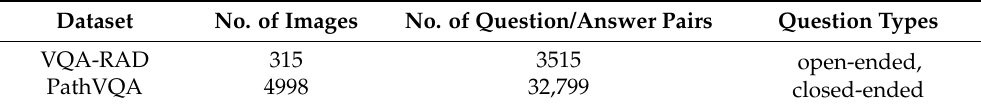
Figure 6. PathVQA images, questions, and answers. Table 1. Medical VQA